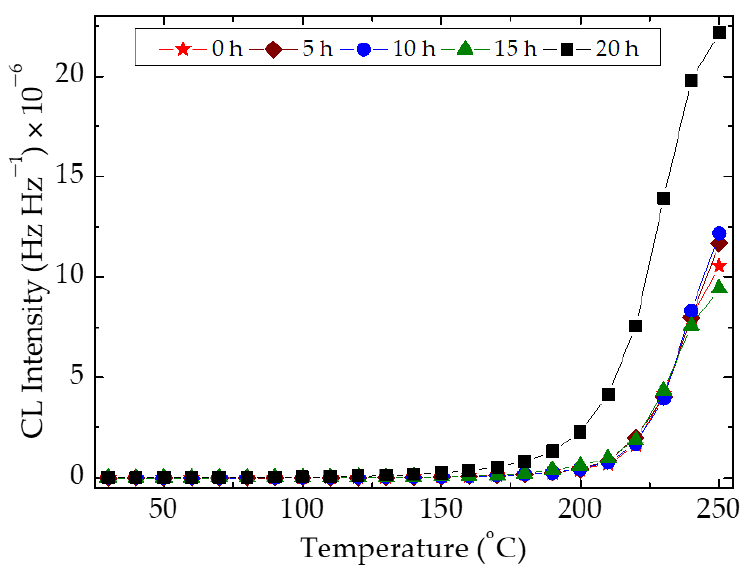
Figure 4. The nonisothermal CL curves recorded on the SIS samples improved by graphene (1 (1 wt%)/rosemary (0.5 wt%) couple after their thermal ageing at 80 ◦ C at various heating times. wt%)/rosemary (0.5 wt%) couple after their thermal ageing at 80 °C at various heating times. Heating rate: 10 ◦ C min − 1 Heating rate: 10 °C min −1 .